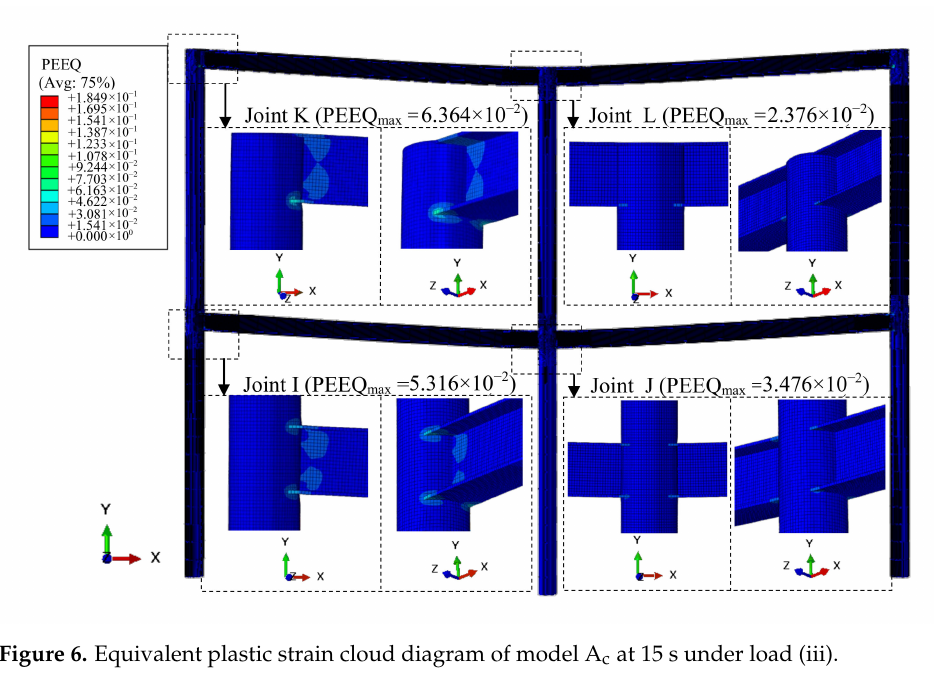
Figure 6. Equivalent plastic strain cloud diagram of model A c at 15 s under load (iii).